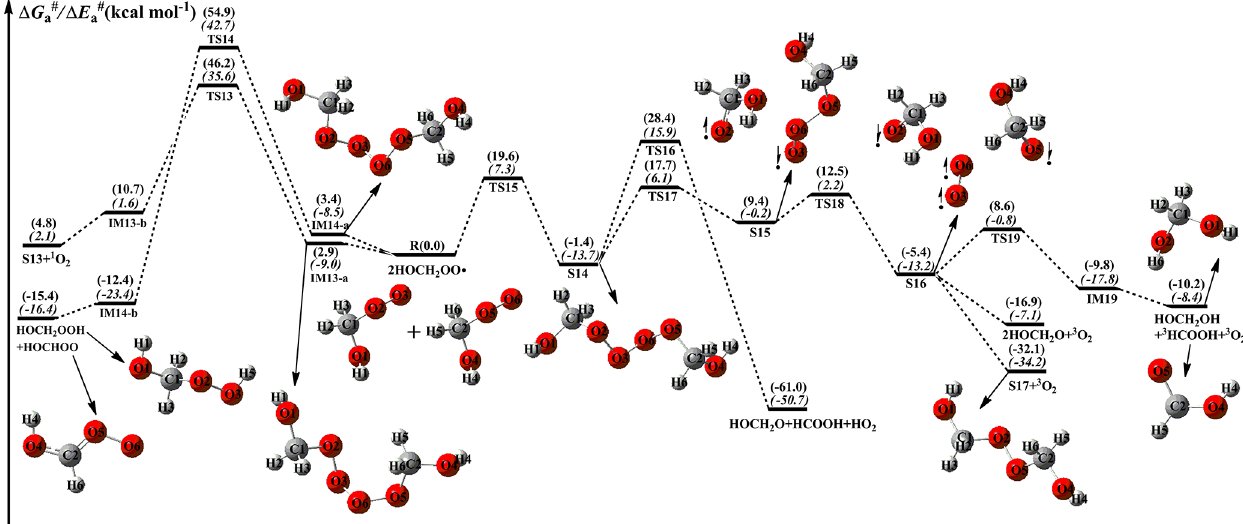
Figure 5. PES ( (cid:49)G # a and (cid:49)E # a , in italics) for the self-reaction of HOCH 2 OO radicals predicted at the M06-2X/ma-TZVP//M06-2X/6- 311+G(2df,2p) level of